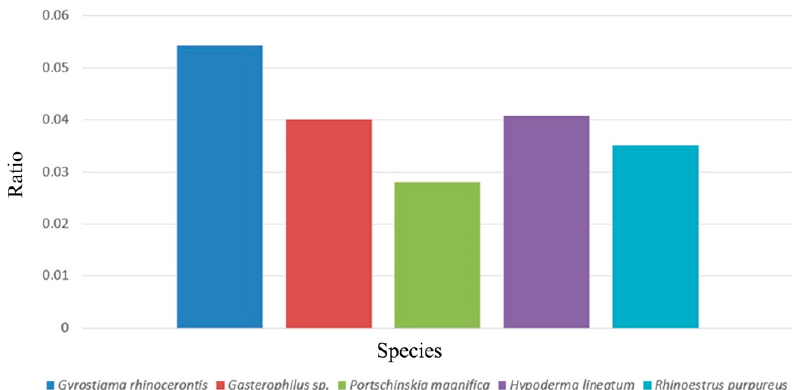
Figure 5. Length ratio of postpedicel and body (ratio = length of postpedicel/length of body) in G. rhinocerontis , Gasterophilus species, Portschinskia magnifica , Hypoderma lineatum, and Rhinoestrus purpureus (using modified data from [25–28,34]).